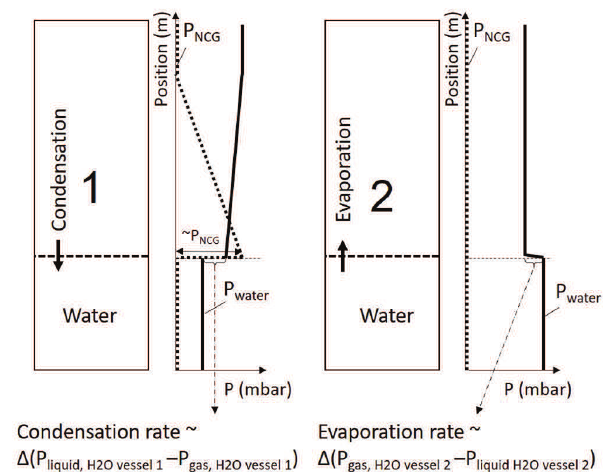
Figure 7. A schematic representation of our thinking model on the pressures of the NCG and water in vessel 1 and 2 during evaporation in vessel 2 and condensation in vessel